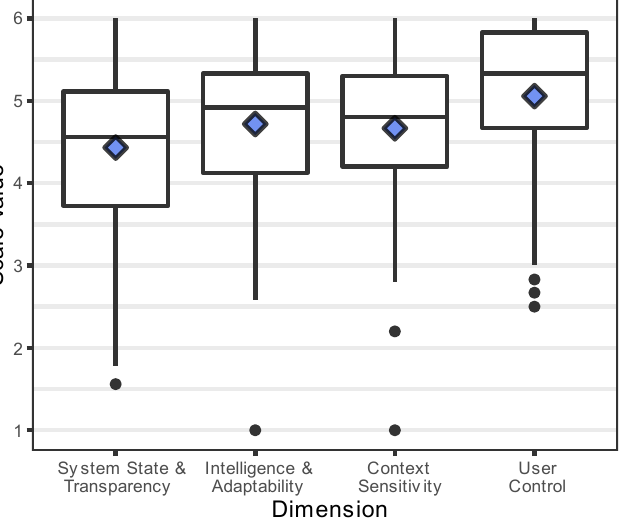
Figure 8. Initial mental model measured using the questionnaire’s 37 items which were answered by 75 truck drivers, diamond indicates mean value (1—not true at all to 6—fully applies). Table 3. Descriptive data of all factors regarding the initial MM of the drivers. System State